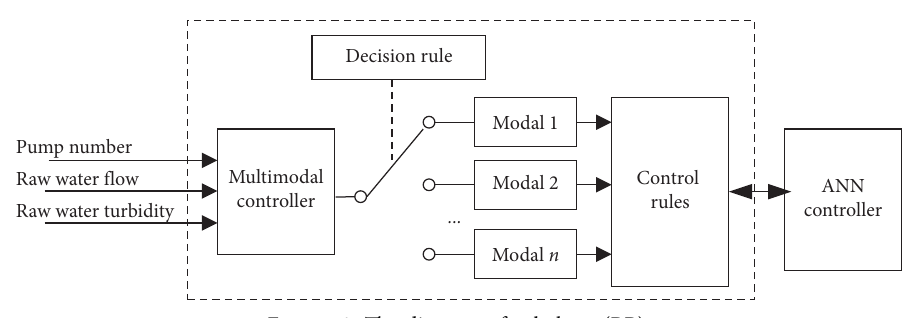
Figure 3: The diagram of rule base (RB).